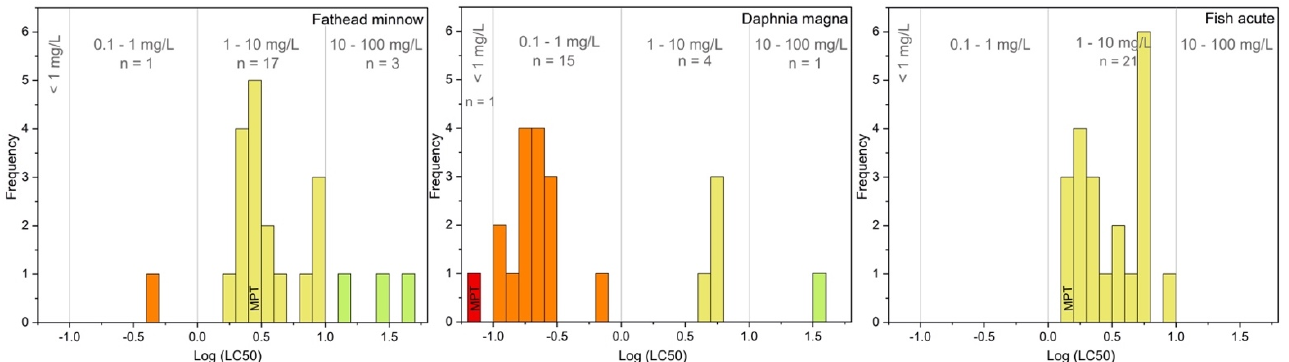
Figure 2. Distribution of TPs estimated Log (LC 50 ) thresholds (mg L − 1 ), based on EPA acute aquatic concerning categories .